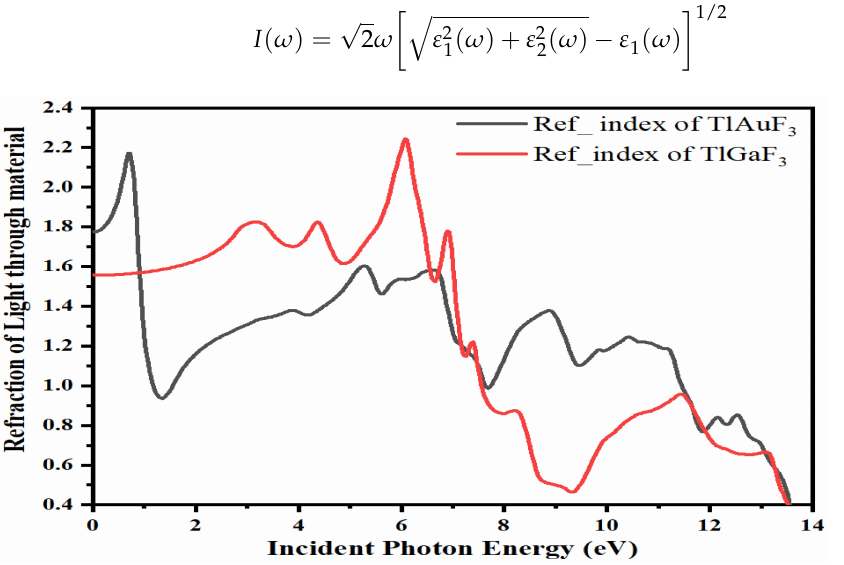
Figure 6. Representation of the relation between refractive indices vs. incident energy for the TMLF 3 (M= Au, Ga) compounds.